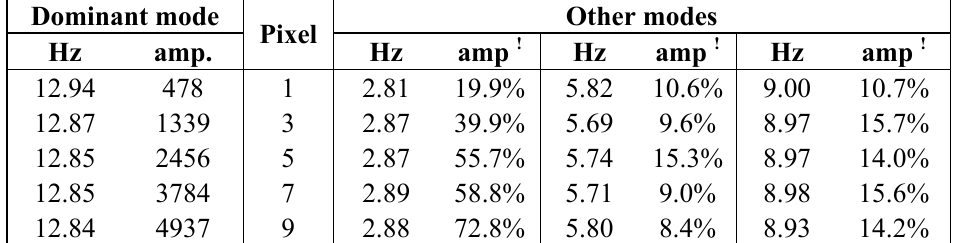
Table 8. Frequency response of the webcam with different black line thickness without enhancing light